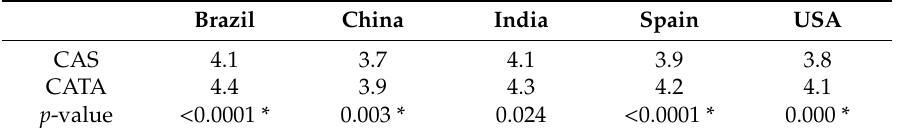
Table 9. Means † and p -values for survey liking for CAS and CATA per